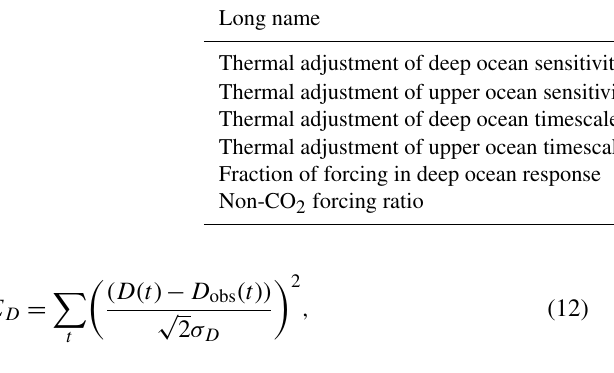
Table 1. A table showing model parameter values and minimum and maximum values allowed in model optimization. Long